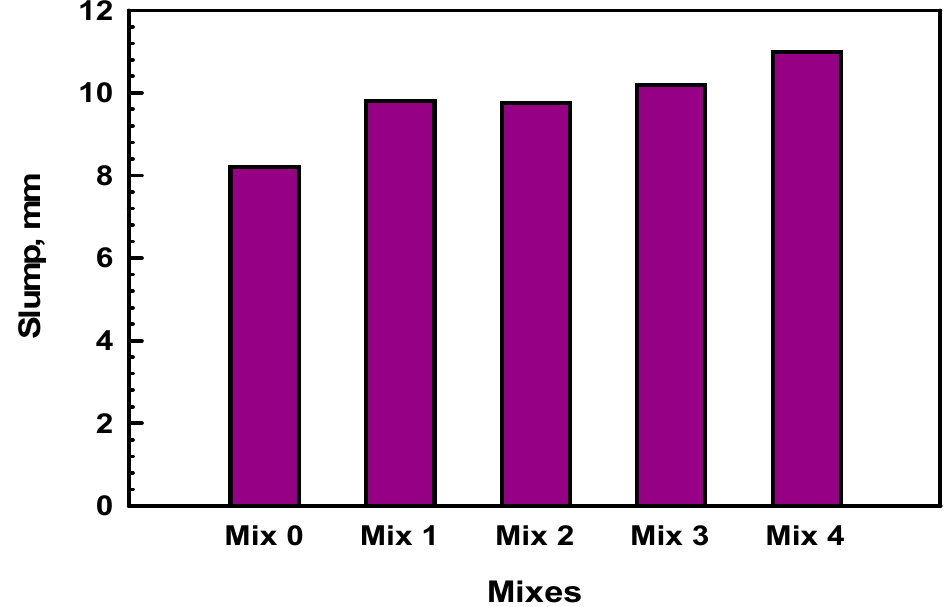
Figure 6. Slump test results for five pozzolanic concrete mixtures in Table 4.